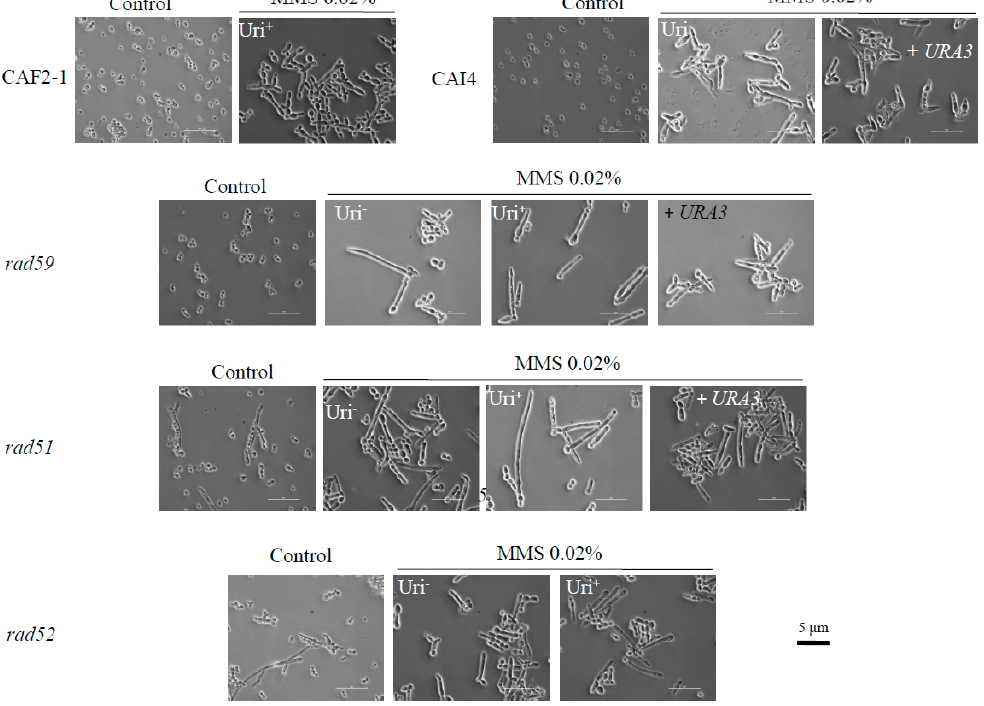
Figure 1. Methyl-methane-sulfonate (MMS) induces constitutive filamentous growth in wild type